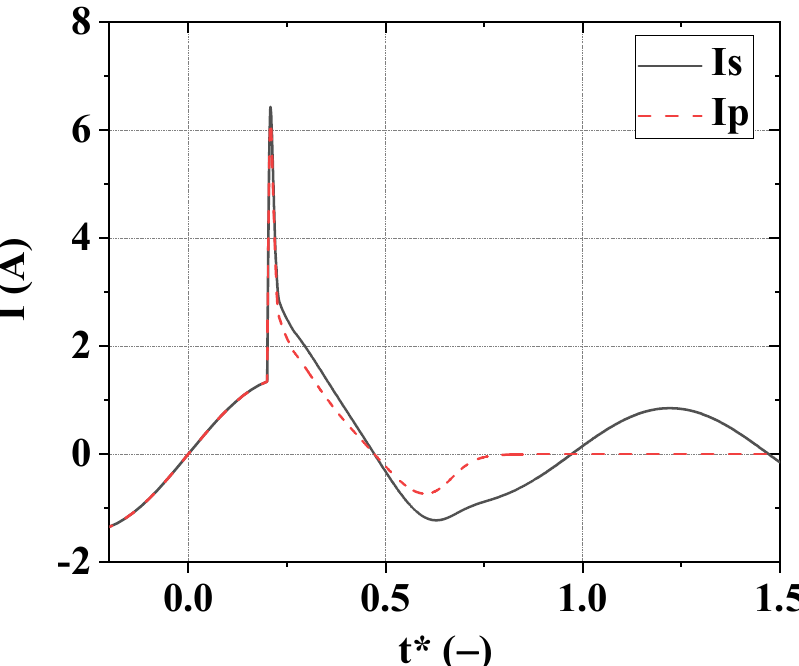
Figure 3. Variation of dimensionless currents of the network I * S = I S / I L (solid line) and fuse box I * F = I F / I L (dashed line) for Cable 1. The dimensionless time is t * = t f , f = 50 Hz, t * 0SC = 0.2.